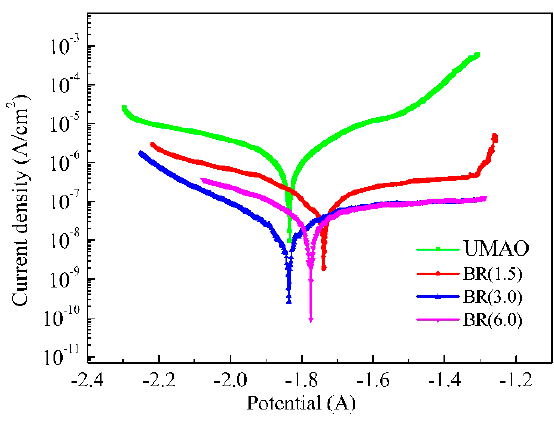
Figure 7. Potentiodynamic polarization curves of various samples.